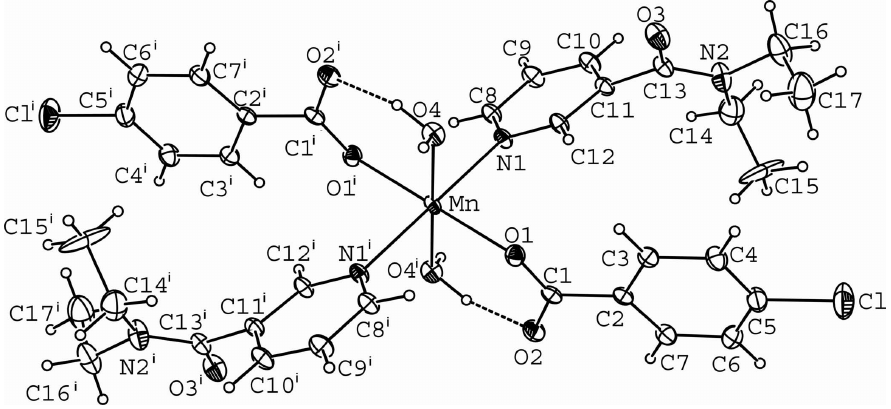
The molecular structure of the title compound. Displacement ellipsoids are drawn at the 20% probability level. Hydrogen bonds are shown as dashed lines. [Symmetry code: (i) - x , 2 - y , - z